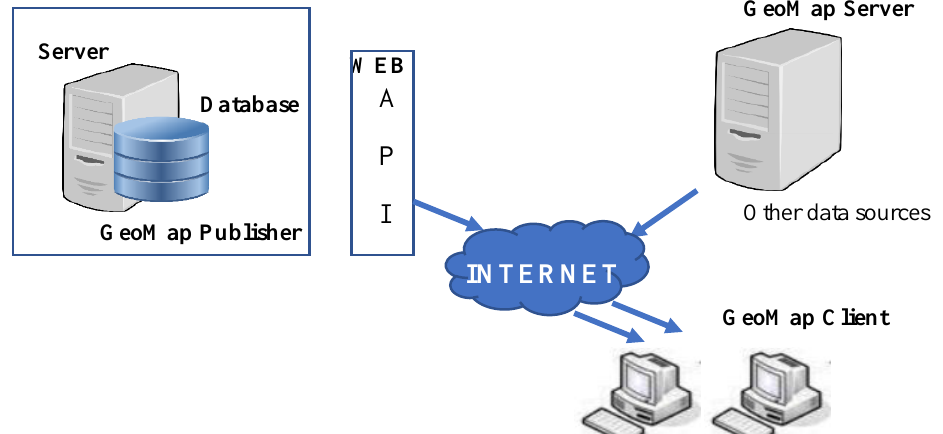
Figure 17: The typical GeoMap architecture over the web utilizing frontier API technology.